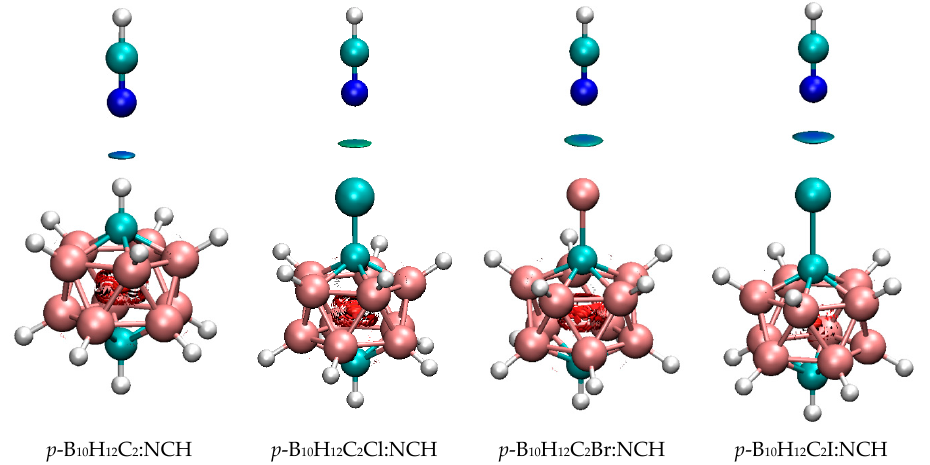
Figure 5. The NCI isosurface (0.05 au) of four of the complexes. The color code indicates strongly attractive (blue), strongly repulsive (red) and weakly attractive or repulsive (green).